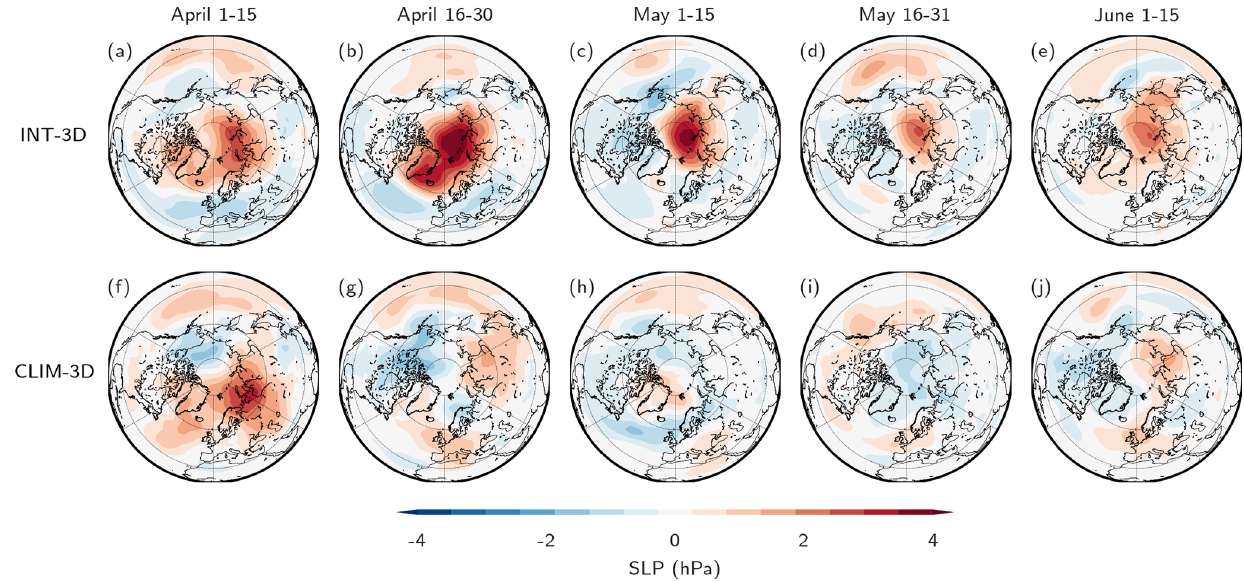
Figure 6. Seasonal evolution of SLP anomalies in high-ozone years in WACCM. Evolution of SLP anomalies from April to June in high- ozone springs in WACCM simulations with interactive ozone chemistry (a–e) and climatological ozone (f–j) . The mean ozone maximum date in INT-3D simulations is March 7, while the mean FSW date is 17 April.